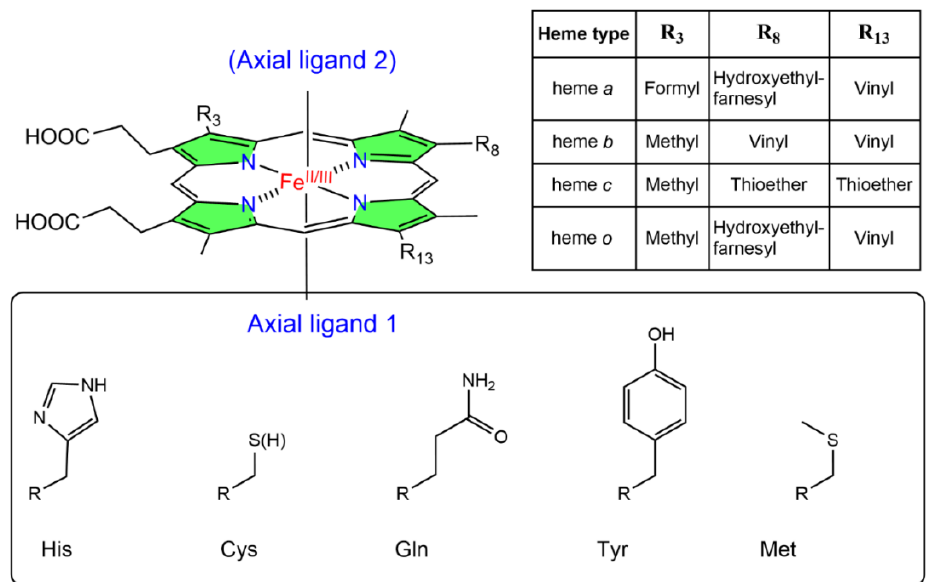
Figure 1. Structures of heme a , b , c, and o . The pyrrol rings are in green. The axial ligands mentioned in this work are reported.